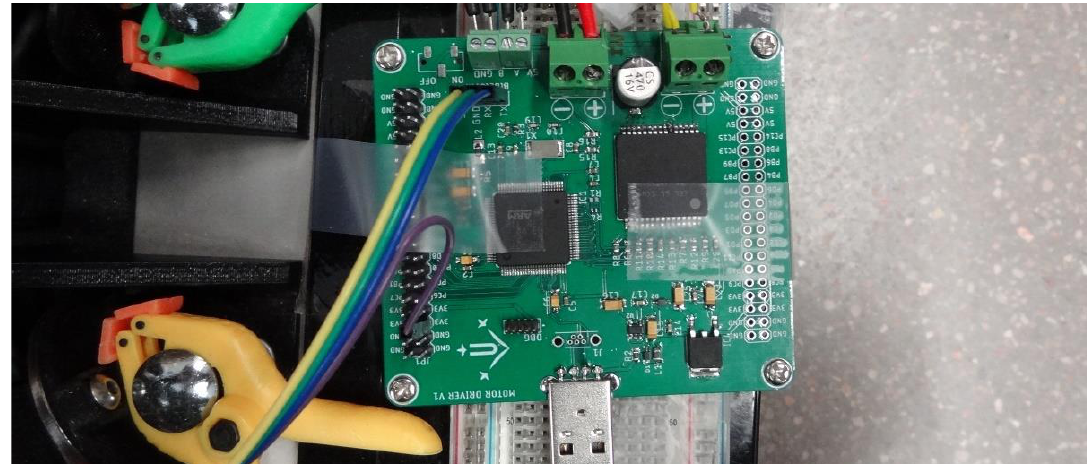
Figure 3. Electronic control board implementing the PID controller.